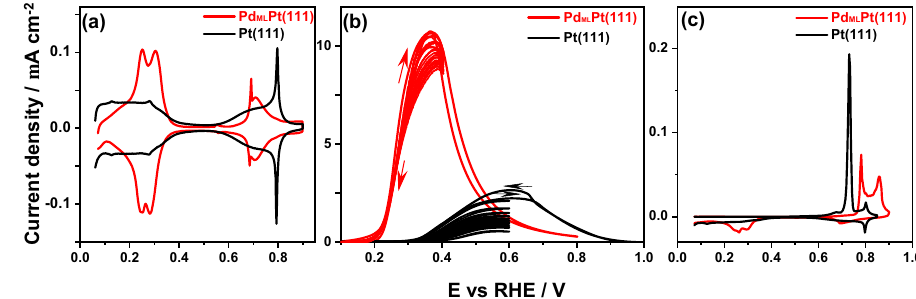
Fig. 1 Voltammetry of Pt(111) and Pd ML Pt(111). a Cyclic voltammogram of Pd ML Pt(111) electrode (red) and Pt(111) (black) in 0.1M HClO 4 . b Voltammograms for the oxidation of formic acid on Pd ML Pt(111) electrode (red) and Pt(111) (black) in 0.1M HClO 4 + 50mM HCOOH. The evolution of 12 cycles on a rotating Pd ML Pt(111) (red) and Pt(111) (black) electrode at 1600 rpm with continuous cycling to two lower vertex potentials: one to the potential of the oxidation peak where no oxidative stripping of adsorbed CO takes place (see panel c ), and one to a higher potential at which adsorbed CO is oxidatively stripped off. Scan rate: 50mVs − 1 . c CO stripping voltammogram for Pd ML Pt(111) electrode (red curve) and Pt(111) (black curve) in 0.1M HClO 4 . Scan rate: 10mVs − 1